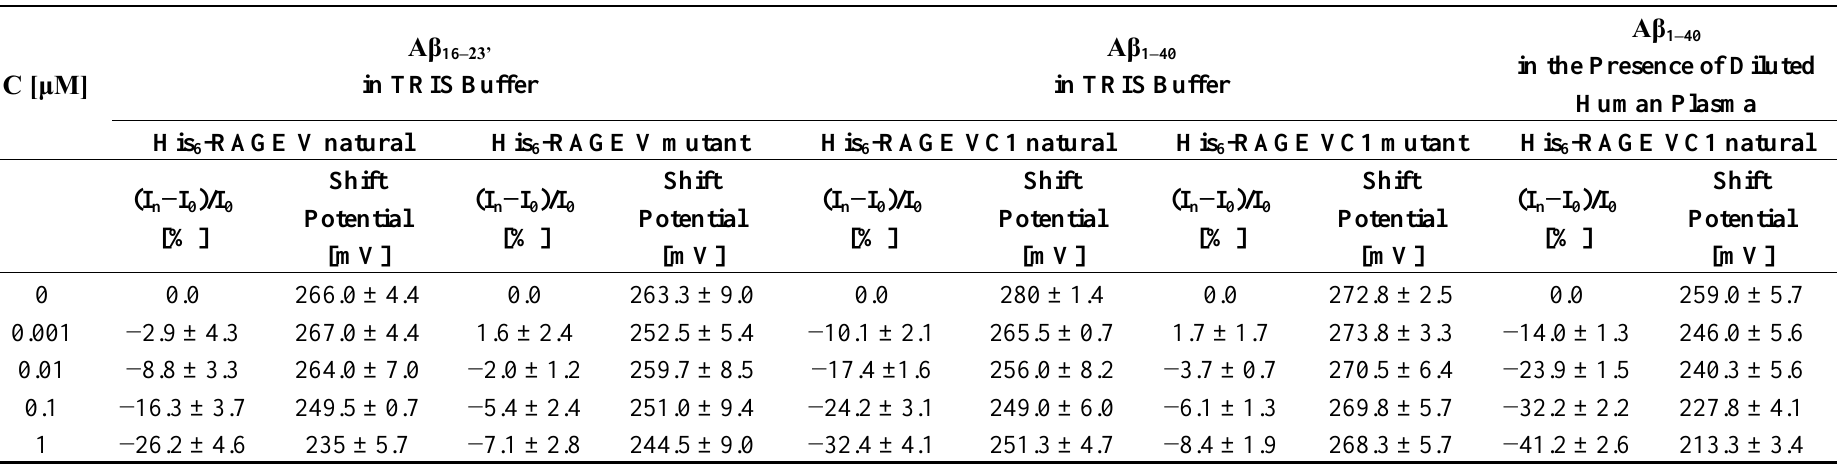
Table 1. The relative Cu(II) redox changes [%] current and peak potential shift [mV] measured with electrodes incorporated His and VC1 domains after incubation with Aβ I –current in the measured in buffer with no analyte; n = 0